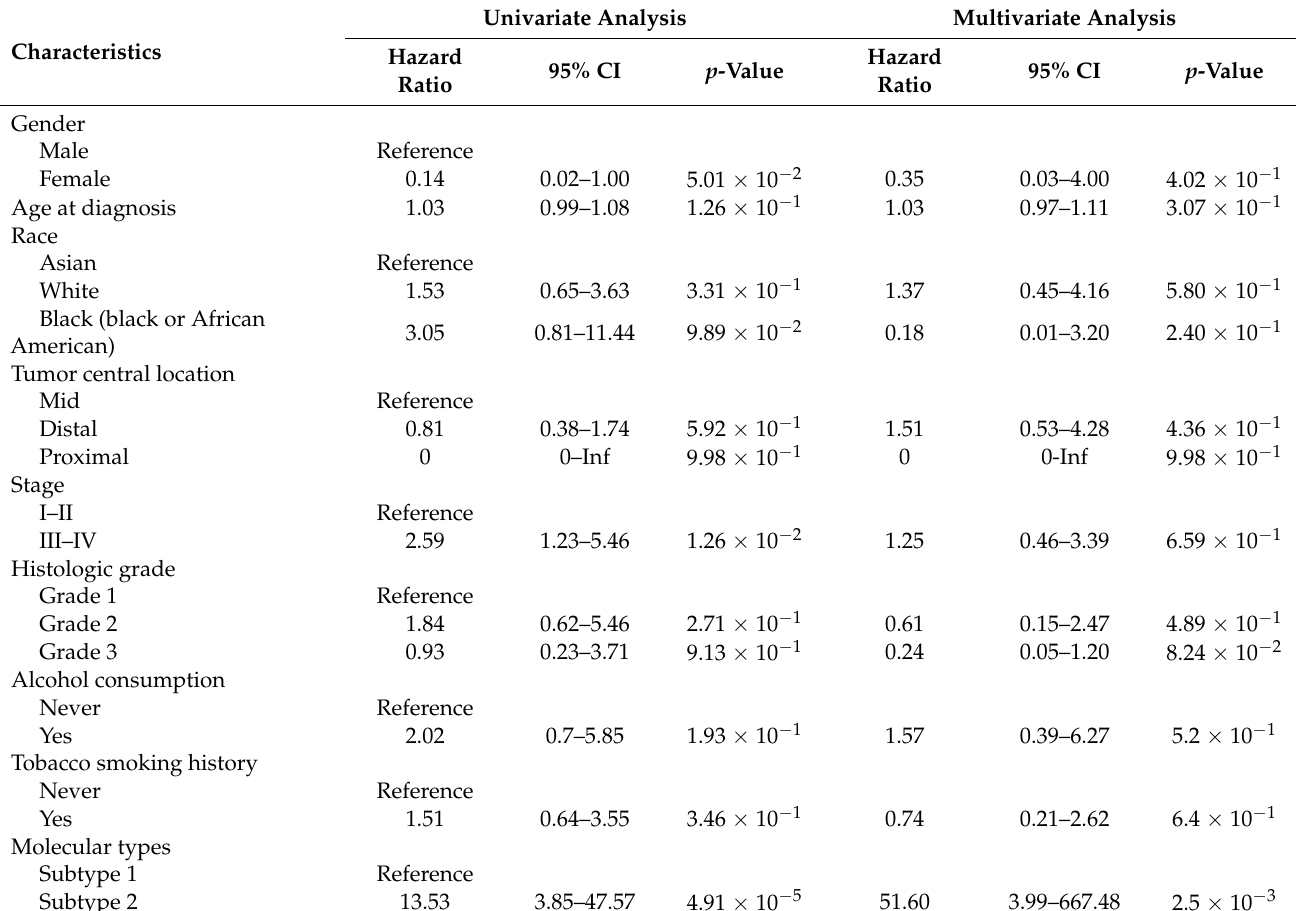
Table 2. Cox proportional-hazard regression analysis for different characteristics in ESCC